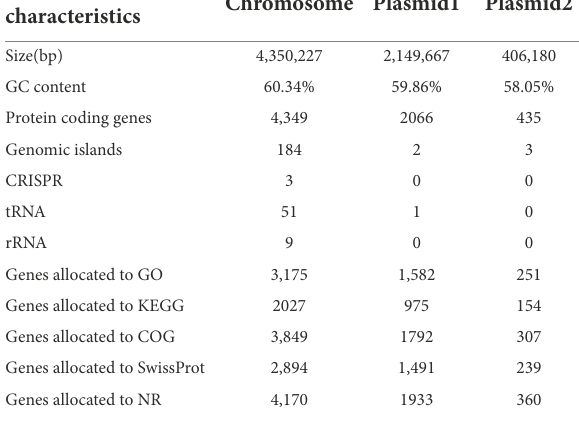
TABLE 3 Genome characteristics of the Rhizobium sp. strain